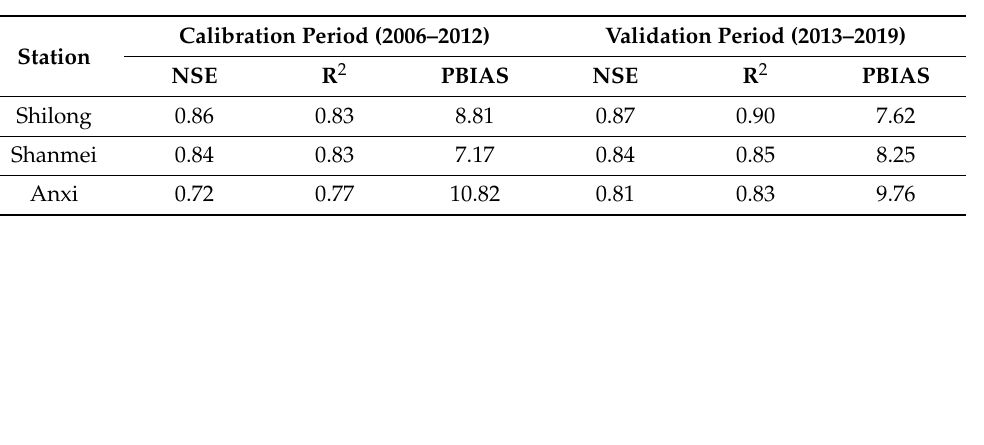
Table 2. Simulation results for the calibration and validation periods for three hydrological stations in the Jinjiang